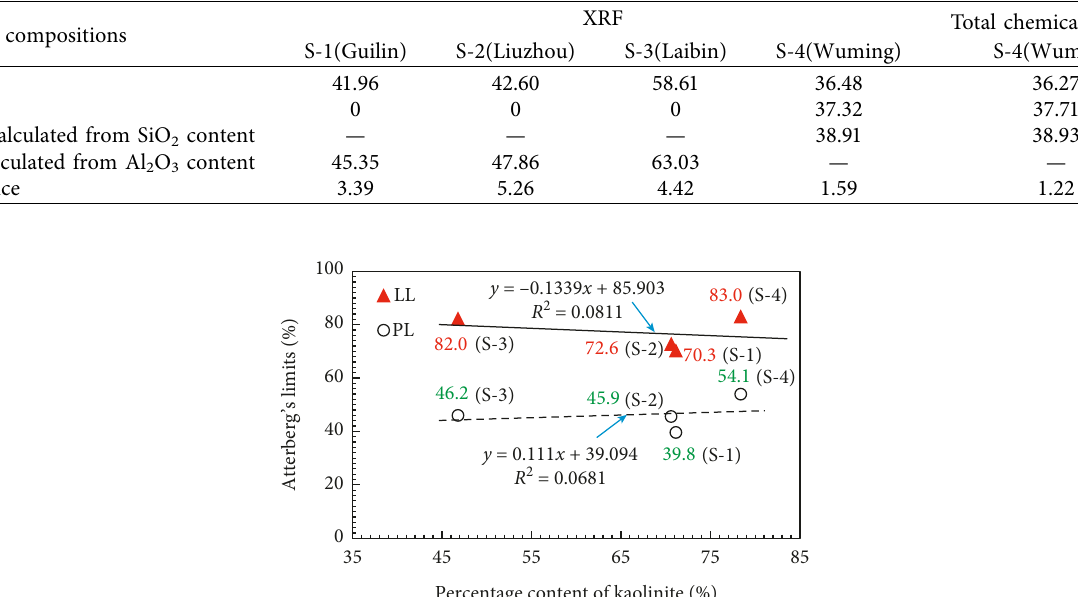
Table 7: Error analysis of calculation results by Bogue’s method.